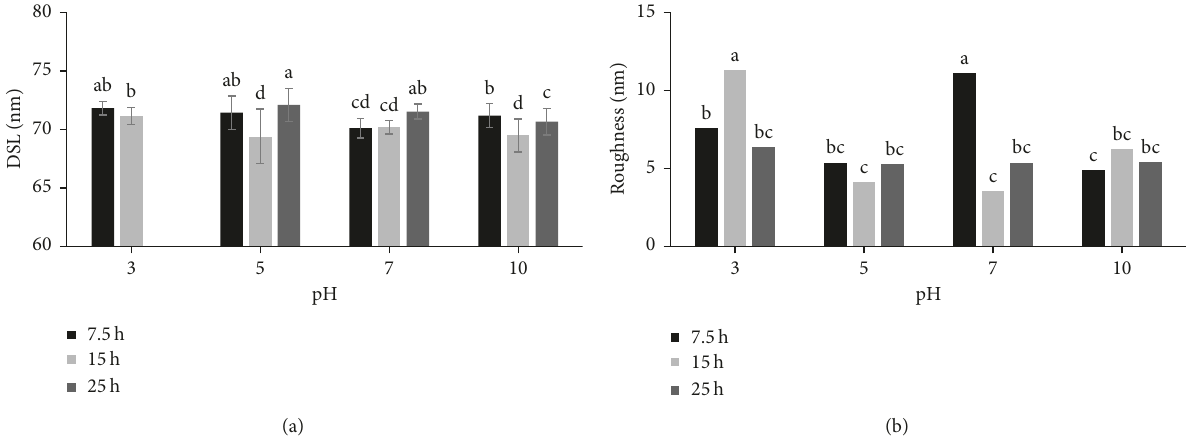
Figure 9: DSL (a) and roughness (b) of collagen fibrils soaked in acidic and alkaline solutions. a, b, c, and d values in the row and column; entries with the same superscript are not significantly different ( p ≥ 0 .